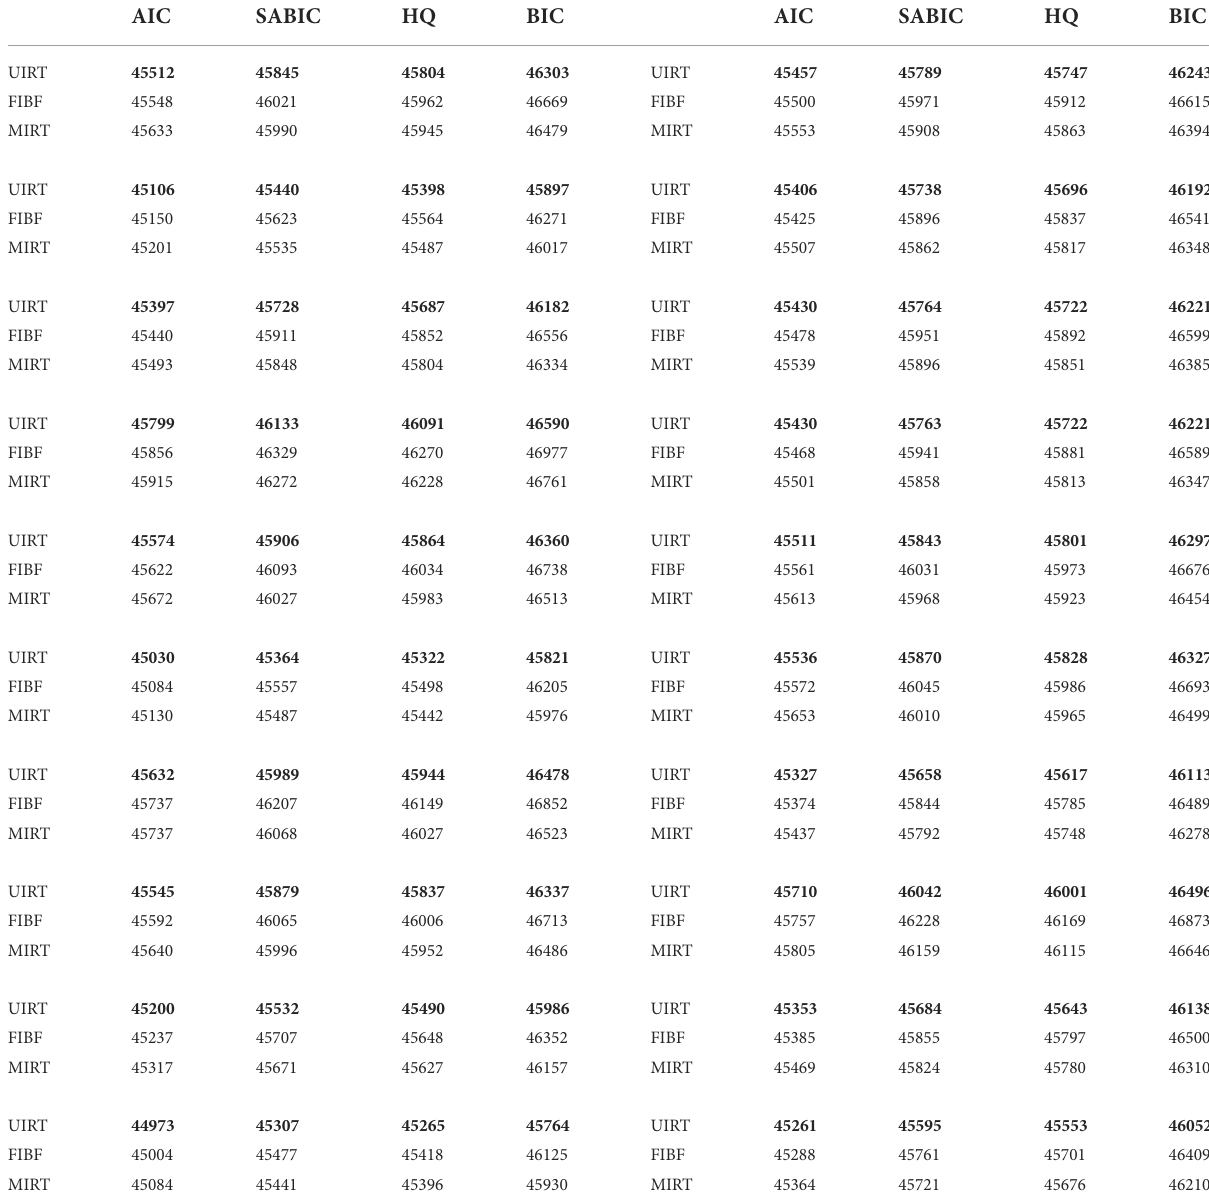
TABLE 4 Four model selection indices (AIC, SABIC, HQ, and BIC) of the three competing models (FIBF, MIRT, and UIRT) under the condition that the generating model is